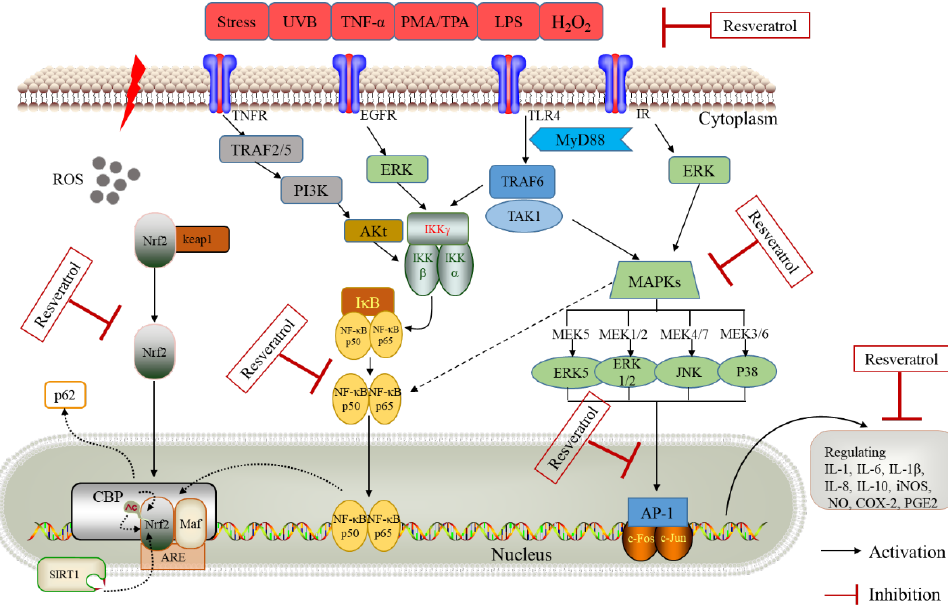
Figure 3. Schematic presentation of possible signaling cascades of resveratrol in suppression inflammatory response. Key abbreviations: UVB, ultraviolet B; TNF-α, tumor necrosis factor alpha; TPA, 12- O -tetradecanoylphorbol-13-acetate; PMA, Phorbol 12-myristate 13-acetate; H 2 O 2 , hydrogen peroxide; LPS, lipopolysaccharide; TLR4, Toll-like receptor 4; MyD88, myeloid differentiation factor 88; TRAF6, tumor necrosis factor receptor associated factor 6; MAPKs, mitogen-activated protein kinases; IκB, inhibitor kappa B; IKK, inhibitor-κB kinase; NF-κBp65, nuclear factor kappa B 3; IL, interleukin; NO, nitric oxide; iNOS, inducible nitric oxide synthase; COX-2, cyclooxygenase-2; PGE2, prostaglandin E2.